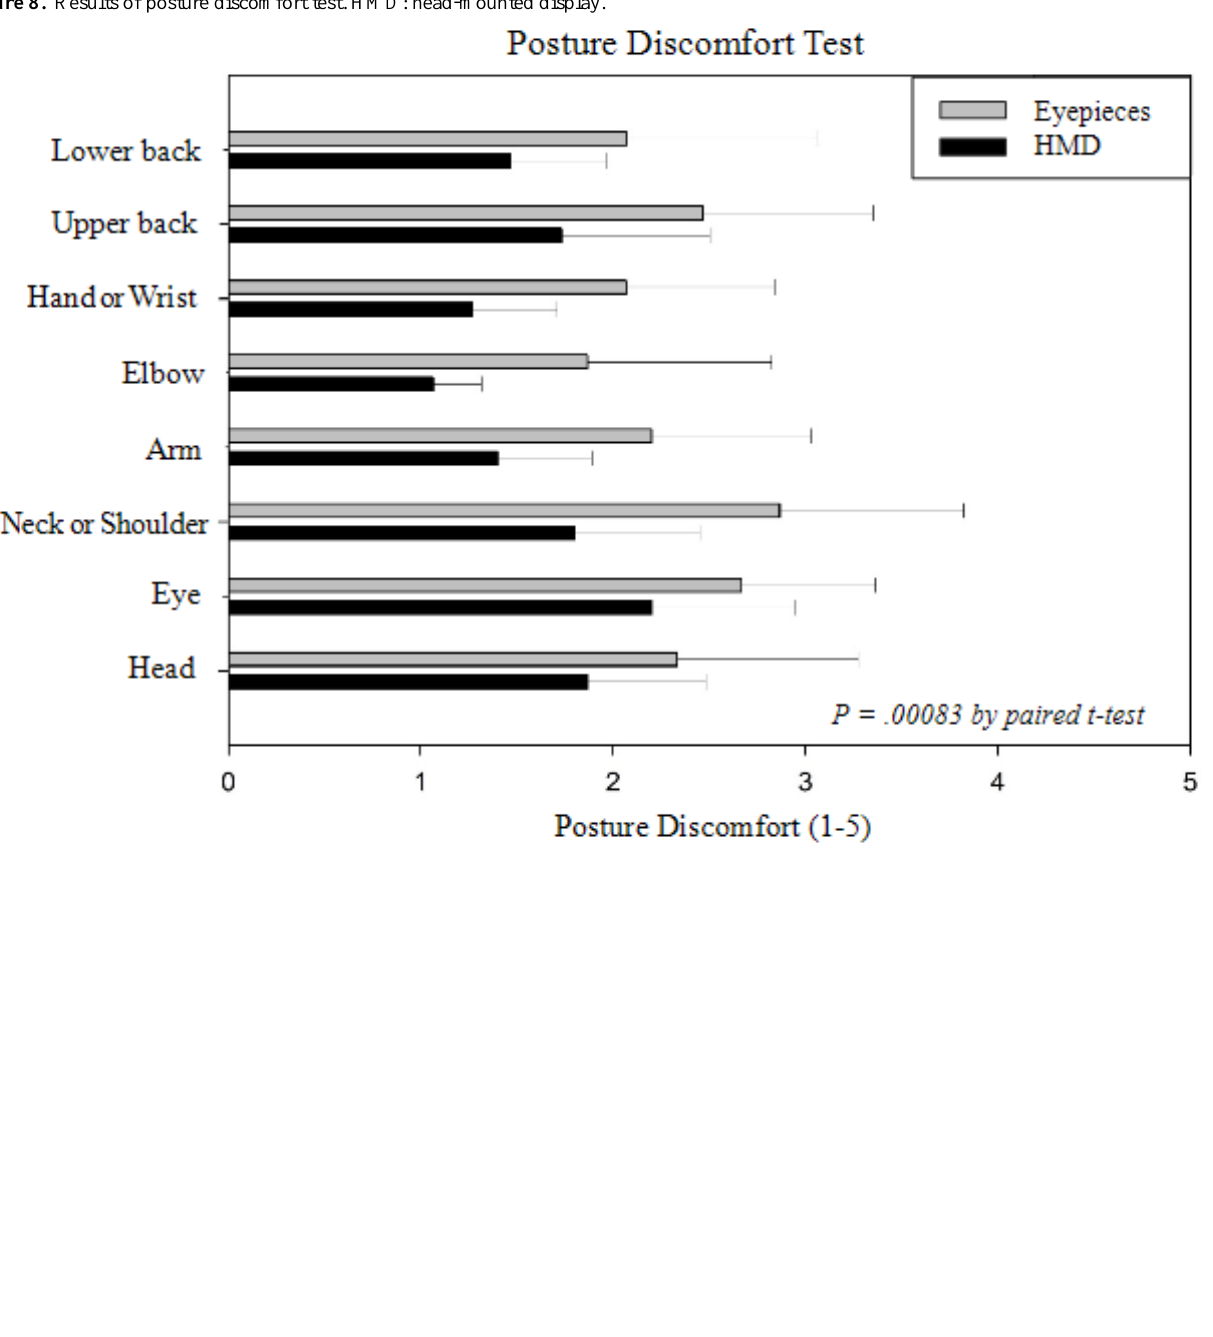
Figure 8. Results of posture discomfort test. HMD: head-mounted